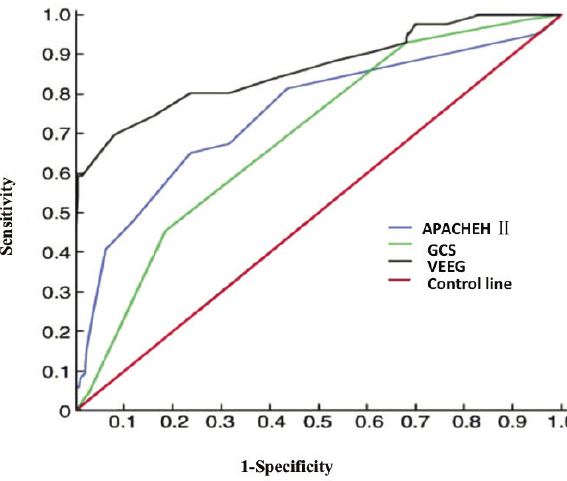
Figure 2: Comparison of ROC curves of three prognostic evaluation methods